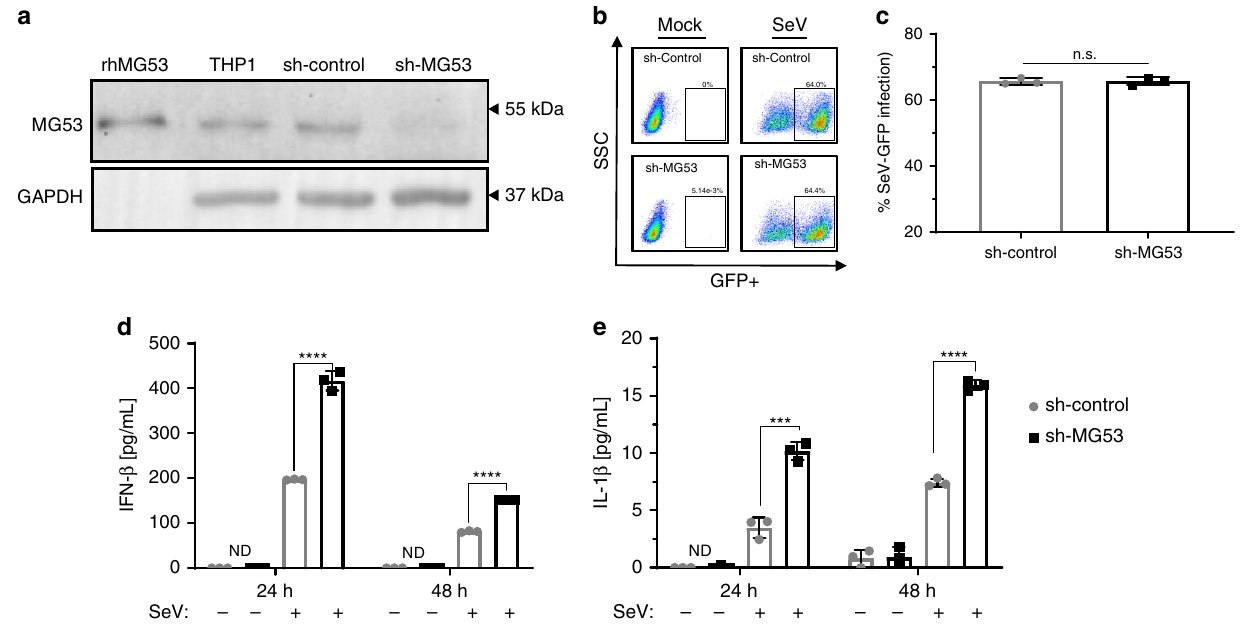
Fig. 2 Knockdown of MG53 leads to a hyper-in fl ammatory response to viral infection. a shRNA lentivirus was used to create stable sh-control and